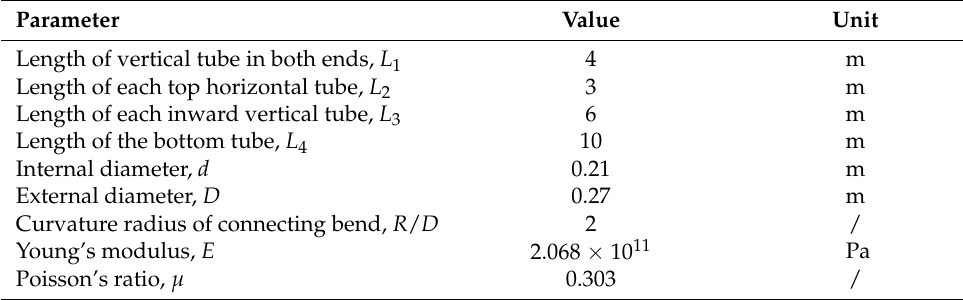
Table 1. Key parameters of the M-shaped jumper investigated. Parameter Value Unit Length of vertical tube in both ends, L 1 4 m Length of each top horizontal tube, L 2 3 m Length of each inward vertical tube, L 3 6 m Length of the bottom tube, L 4 10 m Internal diameter, d 0.21 m External diameter, D 0.27 m Curvature radius of connecting bend, R / D 2 / Young’s modulus, E 2.068 × 10 11 Pa Poisson’s ratio, µ 0.303 /